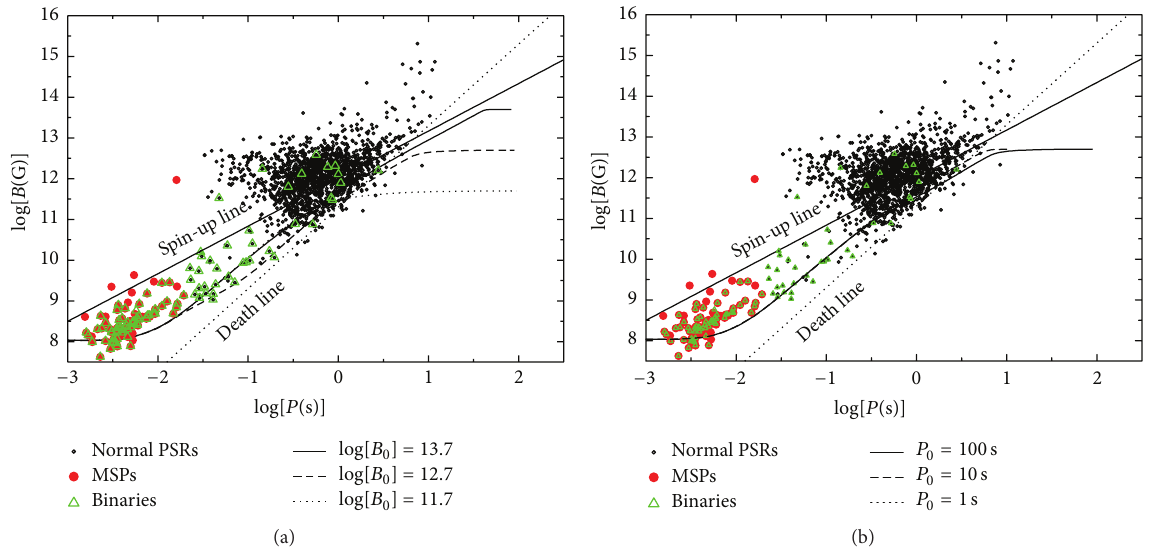
Figure 3: Magnetic field and spin period evolutionary tracks. In (a) tracks are plotted for different initial magnetic fields: 𝐵 0 = 5 × 10 13 G (solid line), 5 × 10 12 G (dash line), and 5 × 10 11 G (dot line), at fixed initial spin period 𝑃 0 = 100 s and accretion rate 10 17 g s −1 . In (b) with different initial periods, 𝑃 0 = 1 s (dotted line), 10 s (dashed line), and 100 s (solid line), at fixed initial field 𝐵 0 = 5 × 10 12 G and accretion rate 10 17 g s −1